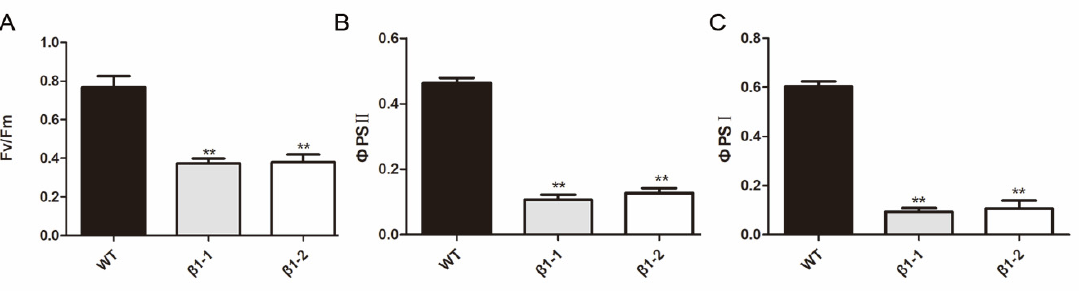
Figure 3. Parameters measurement of WT and OsCpn60 β 1 mutants. ( A ) Maximum photochemical efficiency of PSII, Fv/Fm. ( B ) The actual photochemical efficiency of PSII, Ф PSII. ( C ) The actual photochemical efficiency of PSI, Ф PSI. The data are mean ± SD (n = 3) and ** indicates statistical significance at p < 0.01.